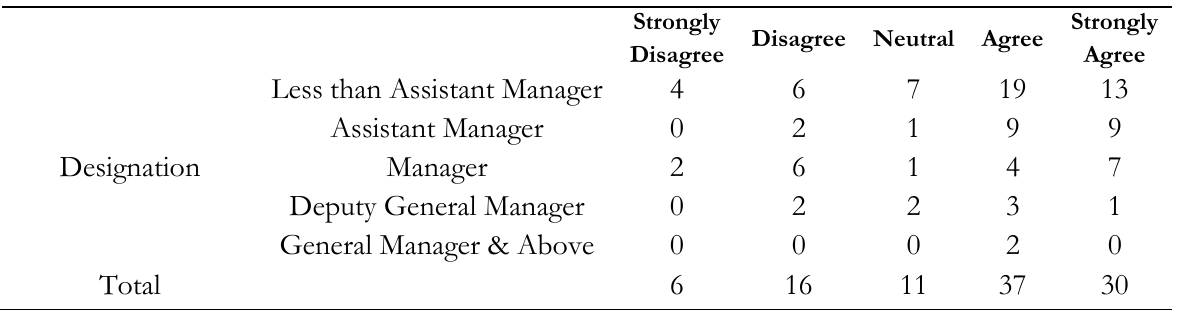
Table 3 : DSG * Q4 Cross tabulation